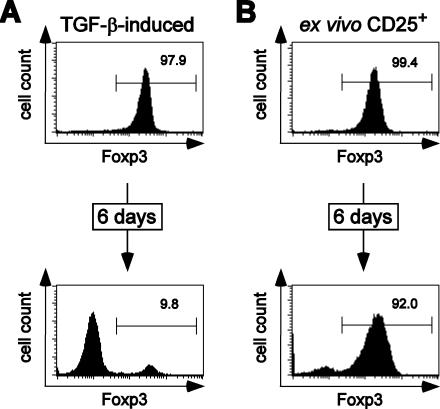
TGF-β–Induced Foxp3+ Tregs Loose Foxp3 Expression upon Restimulation(A) CD25−CD4+ T cells were cultured for 6 d in the presence of TGF-β as described in Figure 6. On day 6, cultured cells were sorted by FACS for CD25+ cells and analyzed for intracellular Foxp3 expression by FACS (upper panel). Sorted CD25+ cells from the same TGF-β-cultures were restimulated for another 6 d in the absence of TGF-β. On day 6, cultured cells were analyzed for intracellular Foxp3 expression by FACS (lower panel). Numbers display frequency of cells within indicated populations.(B) Ex vivo isolated CD25+CD4+ Tregs were analyzed for intracellular Foxp3 expression before (upper panel) and after 6 d in vitro culture (lower panel) by FACS. Numbers display frequency of cells within indicated populations. One representative experiment out of two individual experiments is shown.